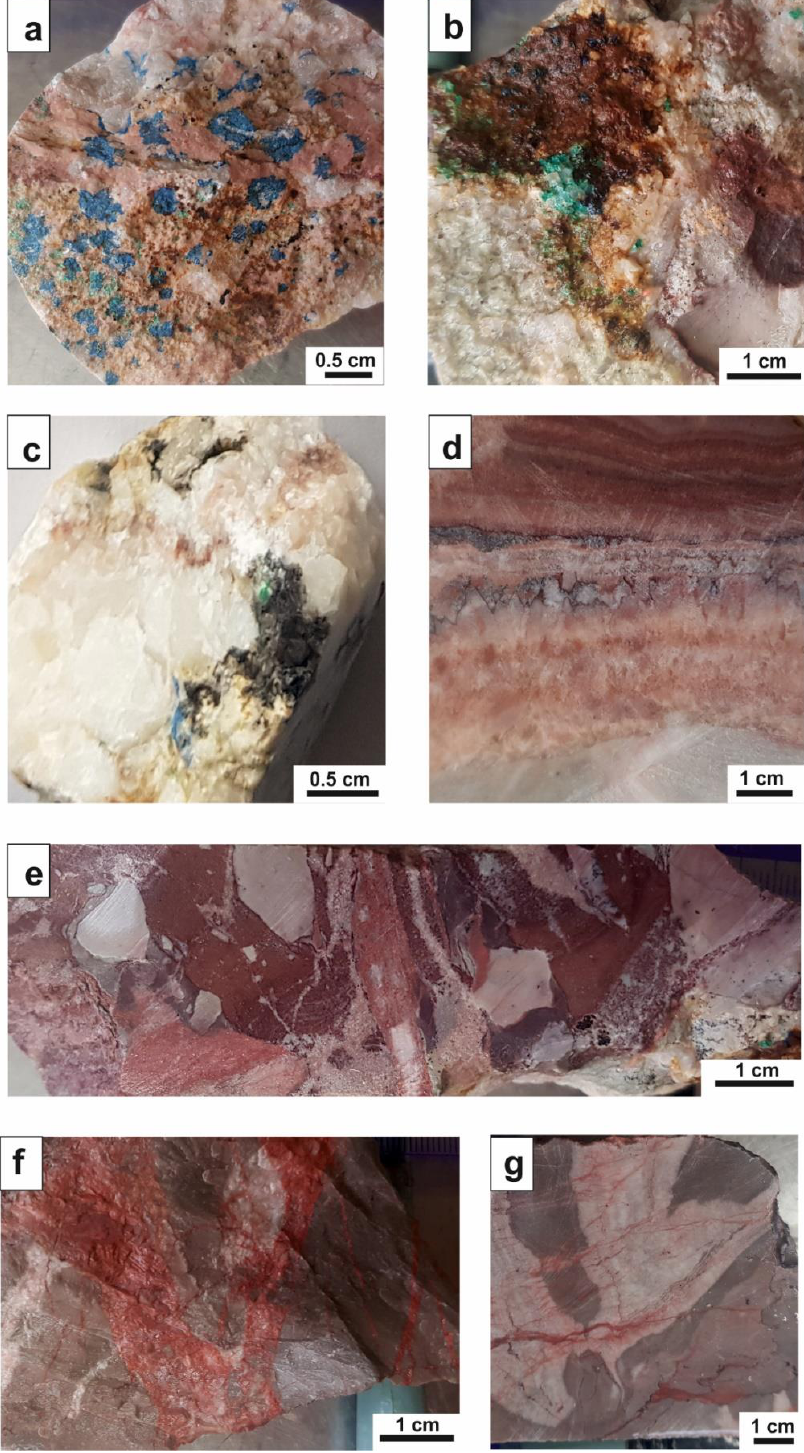
Figure 7. Rock specimens with secondary mineralization: ( a ) azurite (deep-blue), site P6 (sample P6A1); ( b ) malachite, site P1 (sample P1A1); ( c ) nest of so-called black copper ore (aggregate of cuprite, Fe hydroxide and silica) within a white calcite vein, site P7 (sample P7A1); ( d ) complex of the generation of several calcite veins. Pink, white and brown in host limestones, site P5 (sample P5A1); ( e ) breccia cemented by pink and red calcite, site P1 (sample P1A1/1); ( f ) breccia cut by veinlets of Fe oxide, site P3 (sample P3A1); and ( g ) breccia cemented by white calcite, cut by Fe oxide veinlets (red), site P3 (sample P3A3).